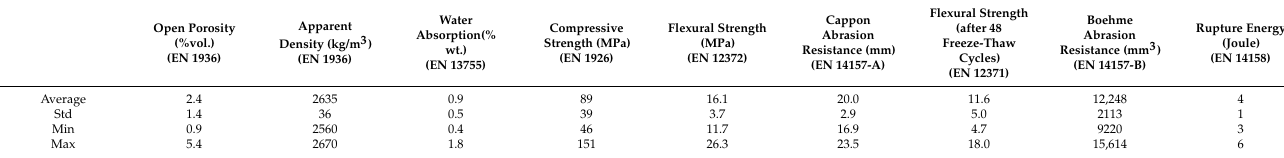
Table 9. Average values of physical mechanical properties determined for